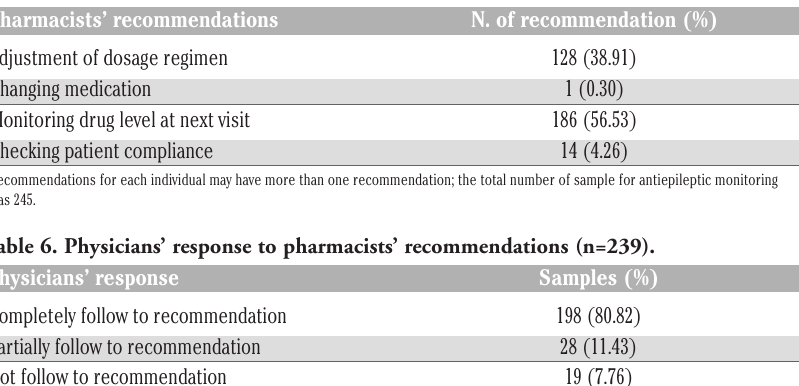
Table 5. Pharmacists’ recommendations (n=239).